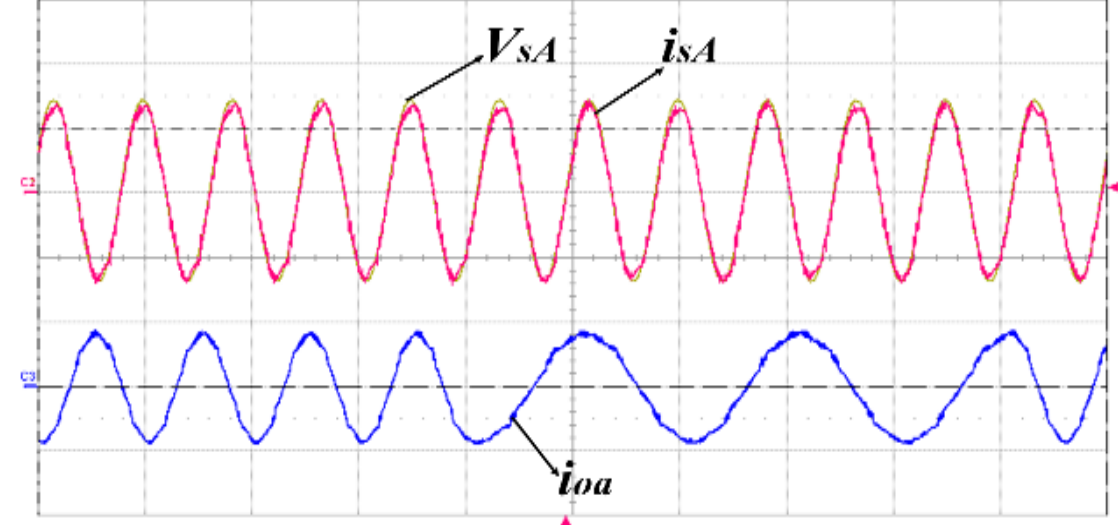
Figure 16. Experimental results of the proposed strategy with the IFRS, where output-current reference amplitude is set to 4.3 A and output-current frequency is changed from 50 Hz to 25 Hz, x-axis 20 ms/div. Waveforms of the source voltage 𝑉 𝑠𝐴 (100 V/div), source current 𝑖 𝑠𝐴 (2 A/div) and output current 𝑖 𝑜𝑎 (5 A/div).